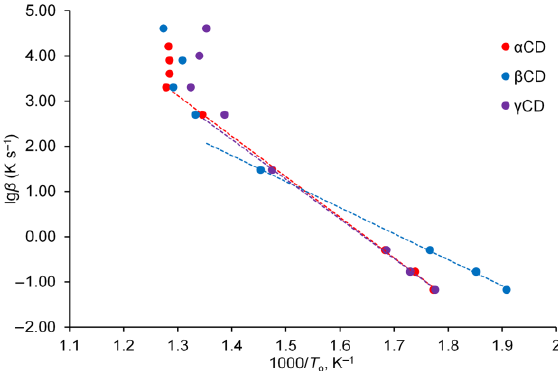
Figure 3. Fitting by Flynn – Wall – Ozawa method for dependence of T o on heating rate.